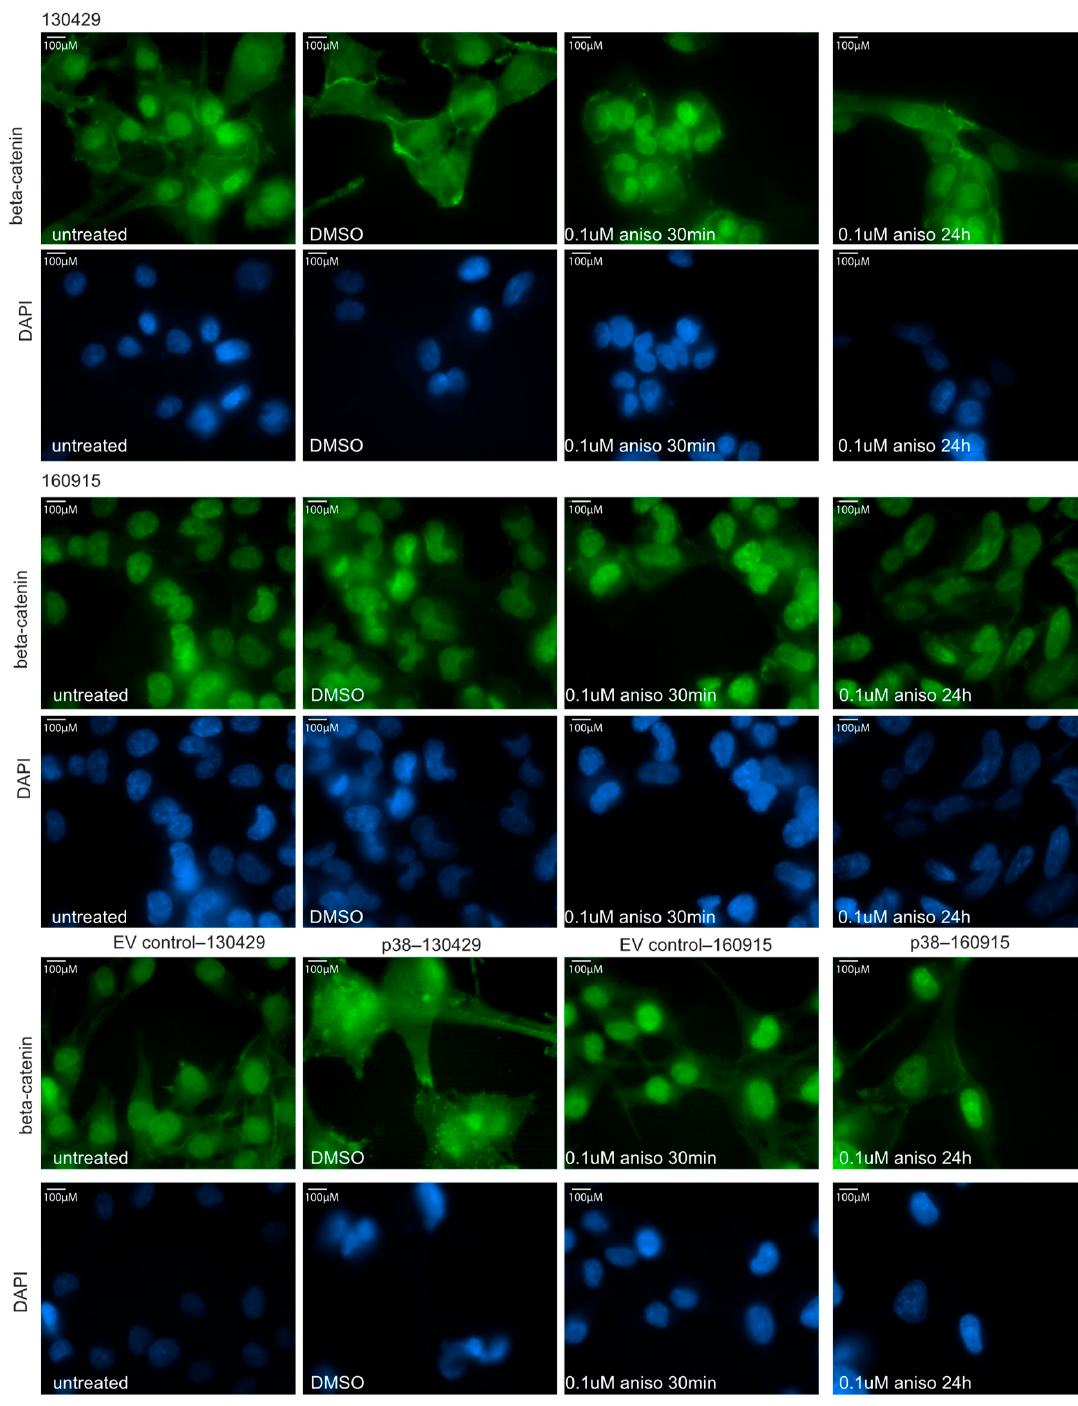
Figure 4. Beta-catenin expression and cell motility assay. Immunofluorescence staining of beta- catenin (green) and nucleus (blue) in cell lines 130429, 160915, EV control–130429/160915, and p38–130429/160915 under DMSO, 0.1 µM anisomycin for 30 min, and 0.1 µM anisomycin for 24 h.